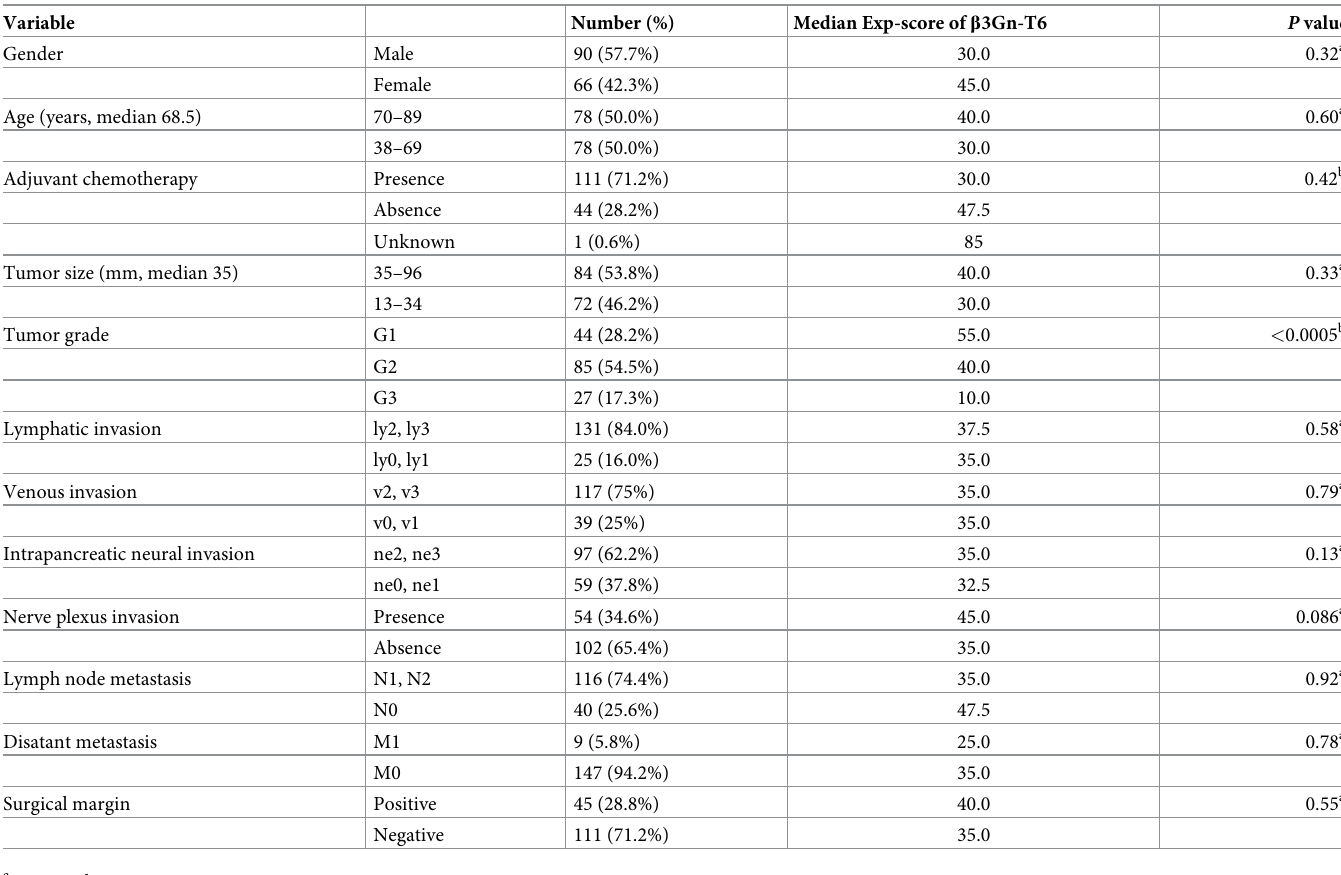
Table 1. Correlations between Exp-scores of β 3Gn-T6 and clinicopathological